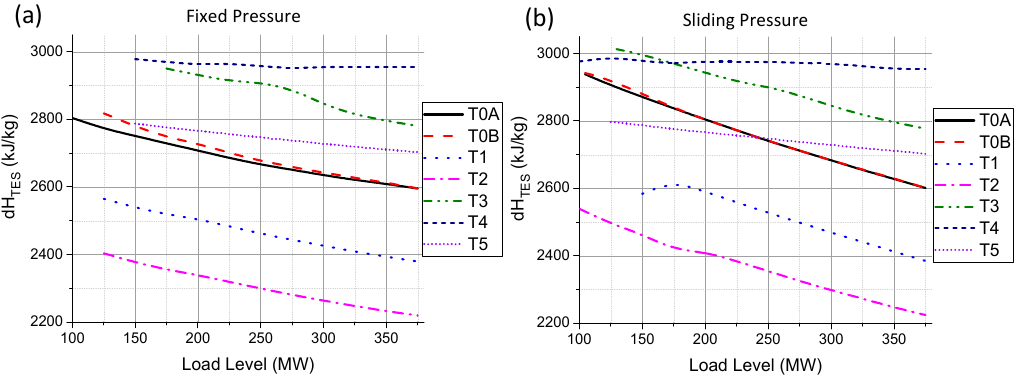
Figure 9. Difference in enthalpy ( dH TES ) at the inlet and outlet point of TES HX in FP ( a ) and SP ( b ) operating mode.